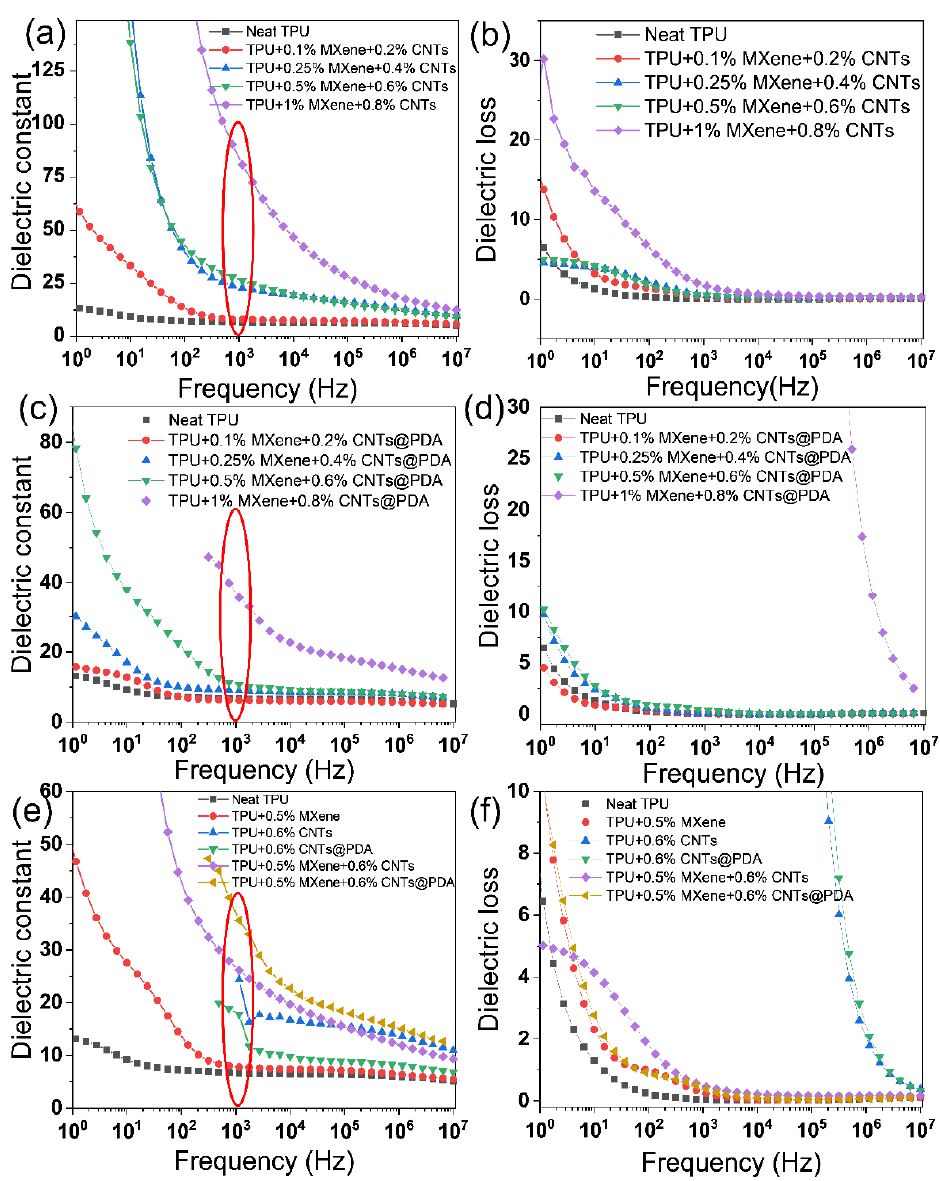
Figure 9. ( a ) Dielectric constant and ( b ) dielectric loss of MXene/CNTs/TPU composite with different filler contents. ( c ) Dielectric constant and ( d ) dielectric loss of MXene/CNTs@PDA/TPU composite films with various filler contents. ( e ) Dielectric constant and ( f ) dielectric loss of TPU composite films with various filler contents.